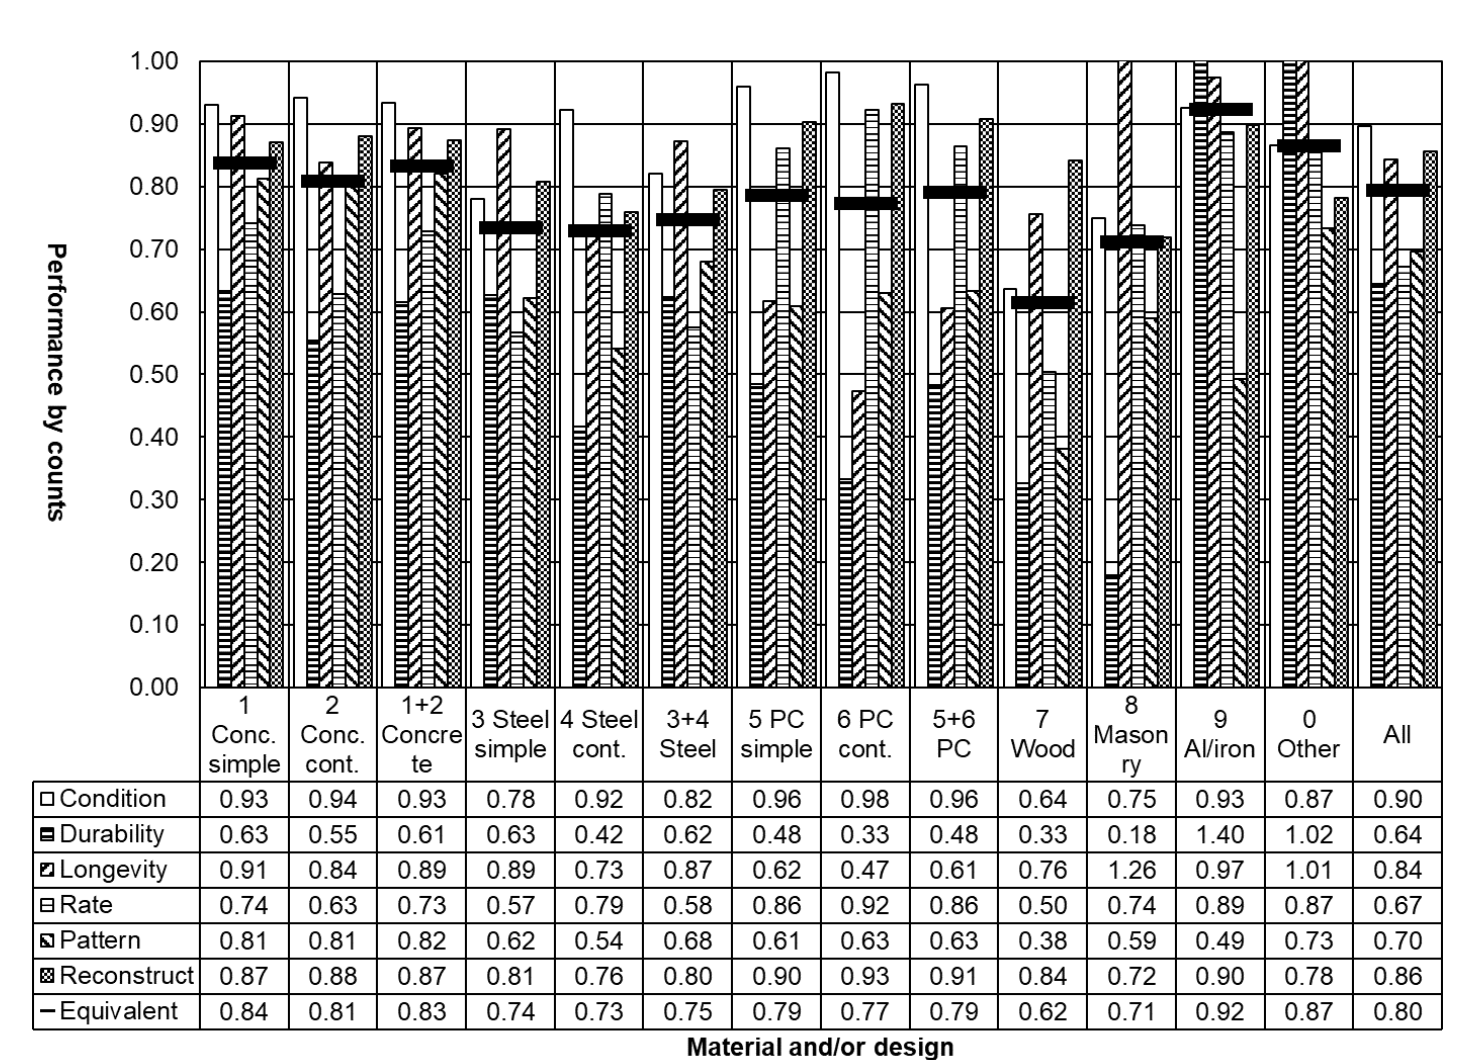
Figure 4. Comparison of structural performances of bridge counts by material and/or design.